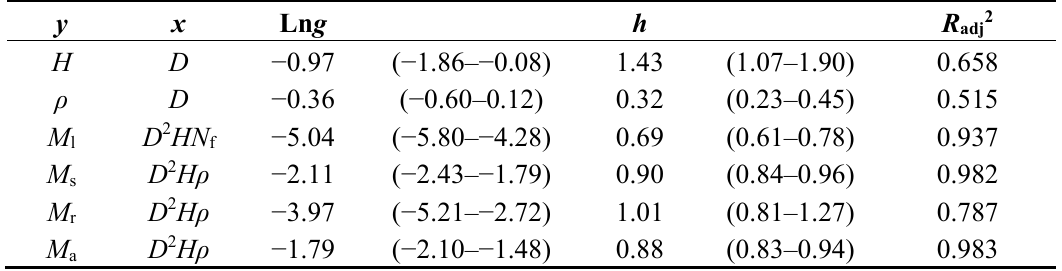
Table 1. As dependent variable y , tree height H (m), stem specific gravity ρ (g·cm − 3